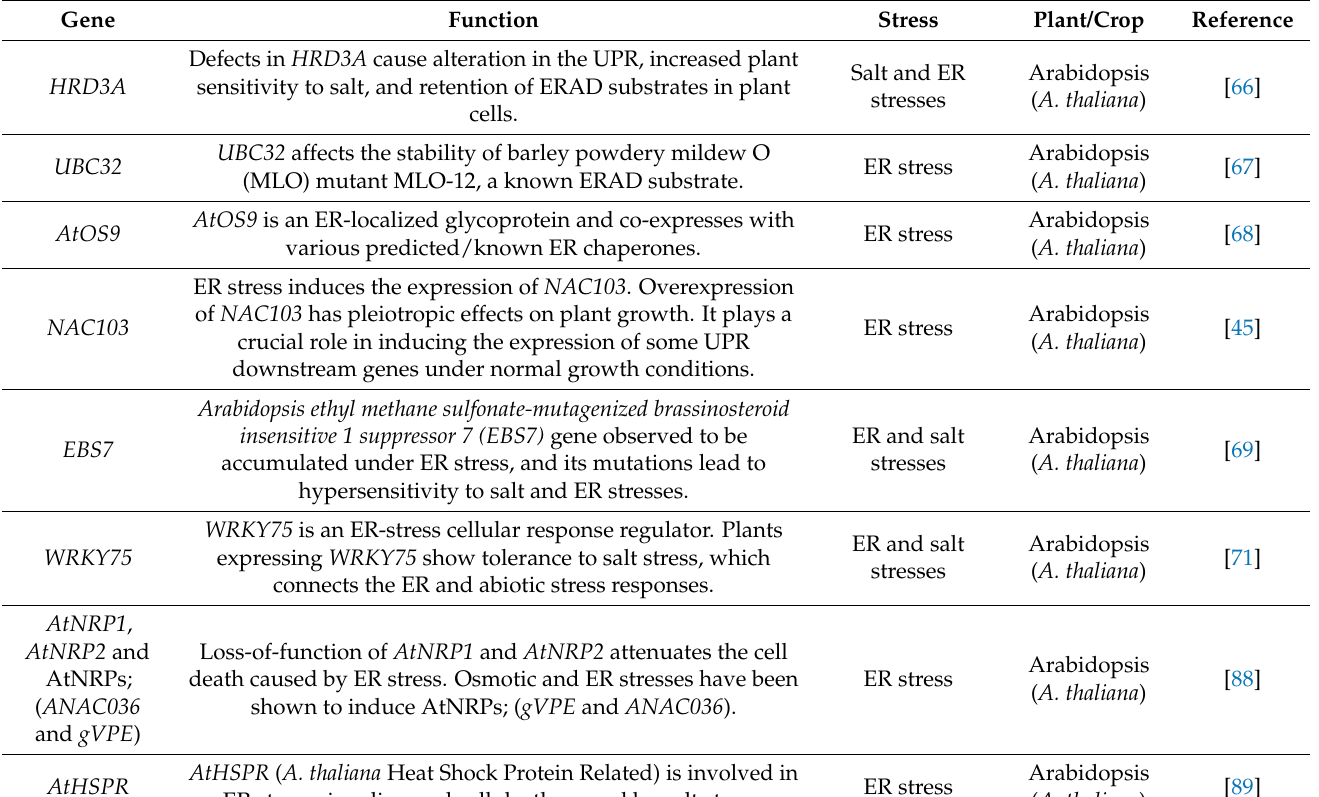
Table 1. Involvement of different genes in ER and other